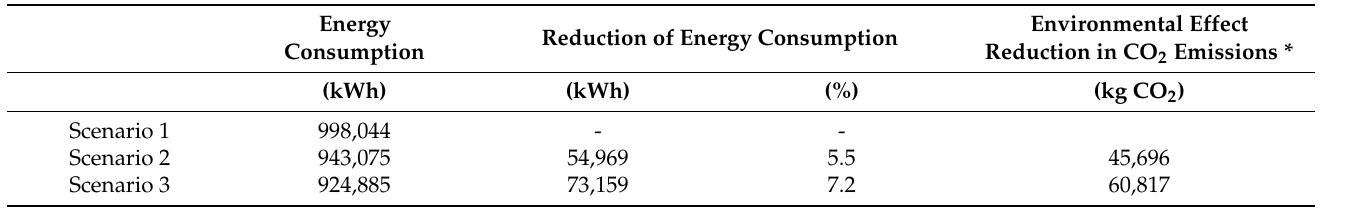
Table 7. Comparison of simulation